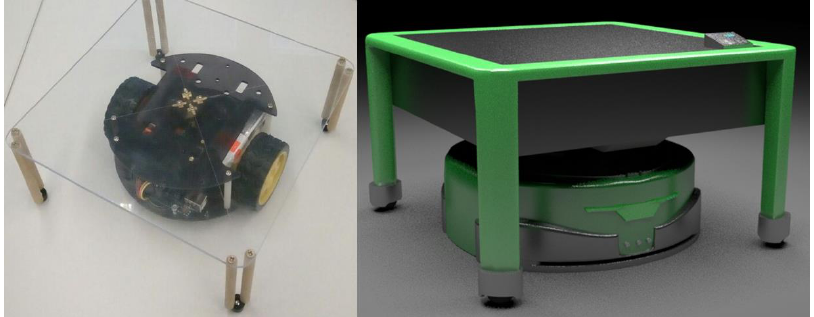
Figure 1. The modular platform (MP) carried by the mobile robotic system (MRS) and their virtual